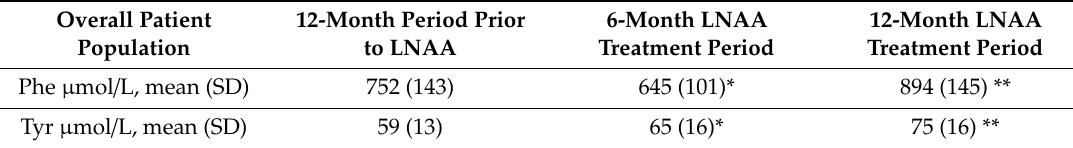
Table 6. Phe and Tyr values at baseline, 6 months and 12 months after the LNAA treatment period for the overall patient